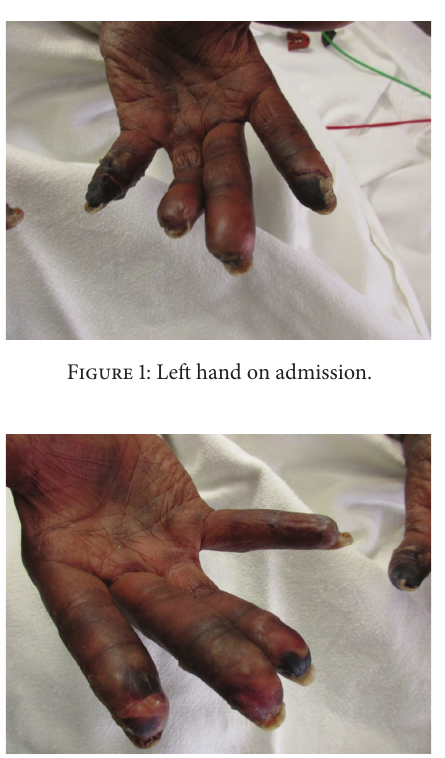
Figure 2: Right hand on admission.